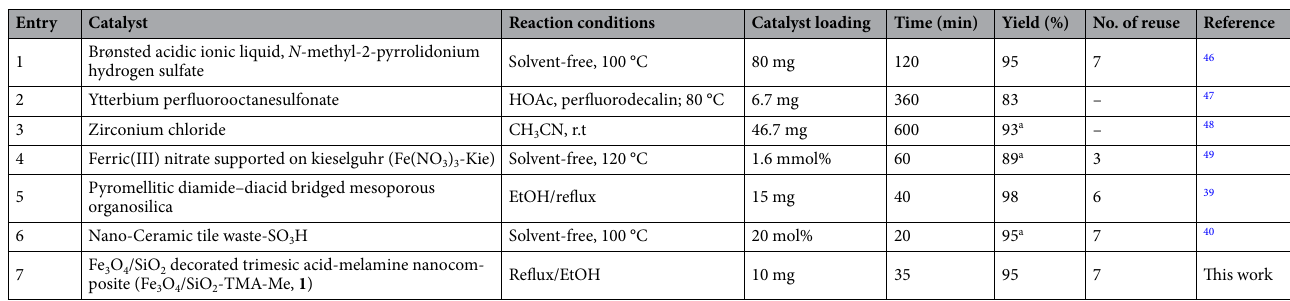
Table 3. Comparison of the results obtained for the synthesis of imidazole 6a using benzoin ( 3 ) in the presence of Fe 3 O 4 /SiO 2 -TMA-Me solid acid ( 1 ) and other